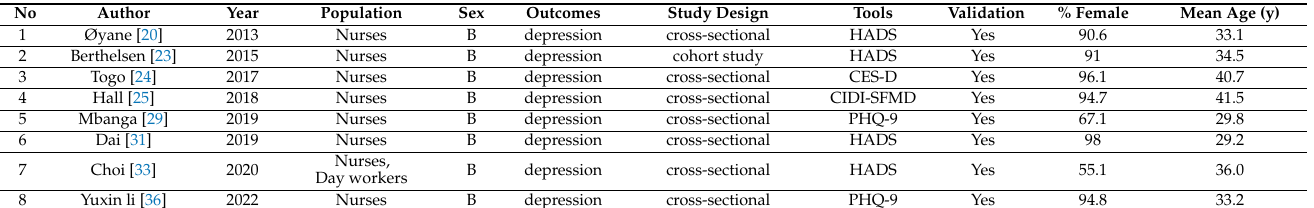
B = Both males and females, HADS = Hospital Anxiety and Depression Scale, CES-D = Center for Epidemio- logic Studies Depression Scale, CIDI-SFMD = Composite International Diagnostic Interview Short Form, Major Depression section, PHQ-9 = 9-item Patient Health